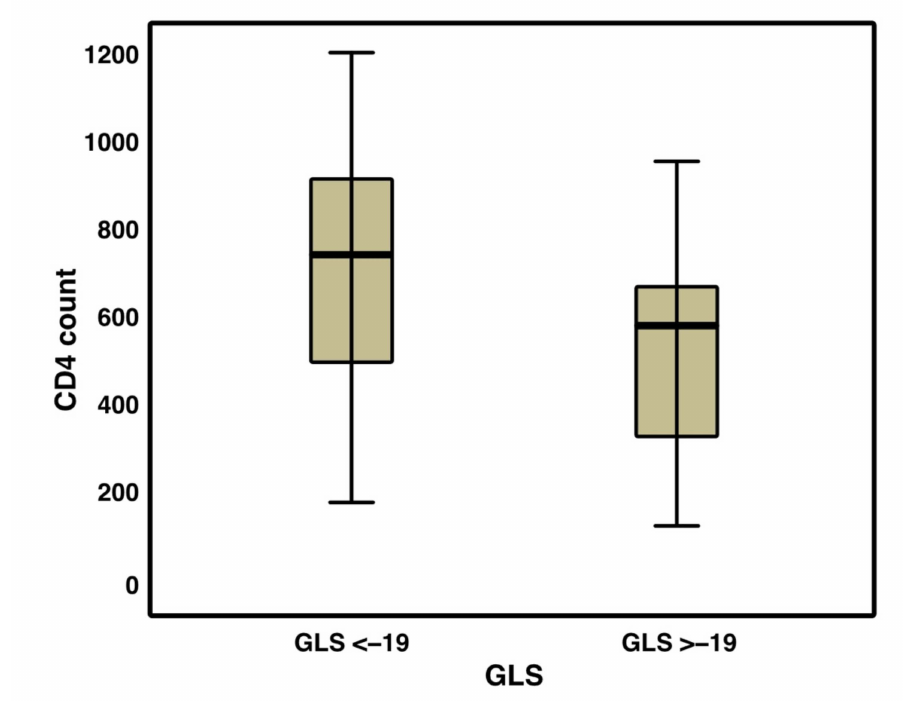
Figure 3. Correlation between GLS value and CD4+ lymphocytes count (cells/mm 3 ) ( p =